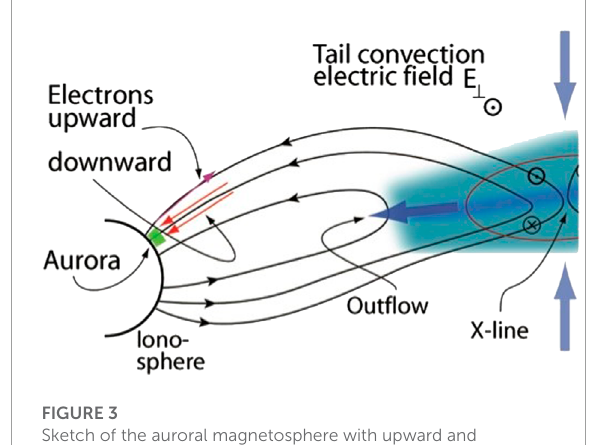
FIGURE 3 Sketch of the auroral magnetosphere with upward and downward electron fluxes (red arrows) originating from the tail crossing the presumable source region of AKR, which is above the aurora (green spot) and some variable fraction of the electron arrows long around roughly 1,000 km–3,000 km altitude (above earth’s surface). This region is connected to the tail plasma sheet via the geomagnetic field with downward accelerated electron fluxes resulting from reconnection. The downward currents are transported by upward cool ionospheric electrons of higher density [adapted from (Treumann and Baumjohann,